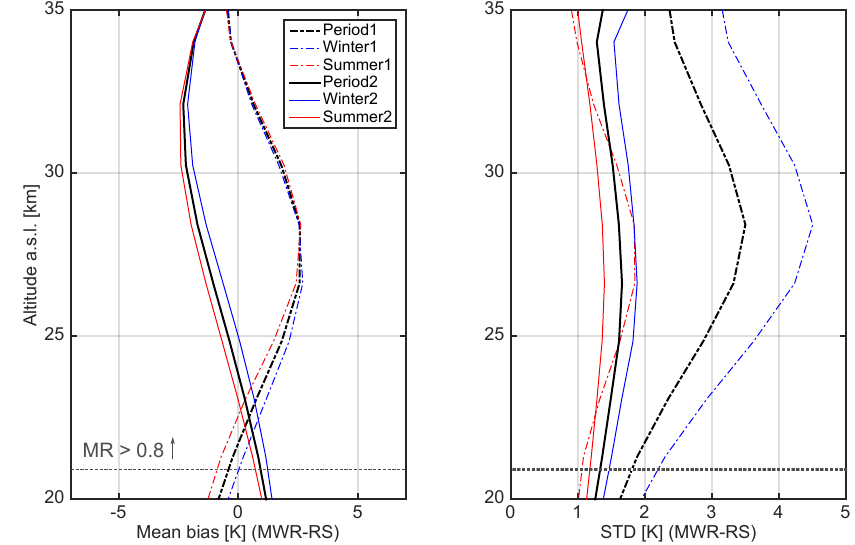
Figure 8. Mean temperature biases and standard deviations between TEMPERA and RS. A total of 1489 profiles have been compared (Period 1: 809 profiles, dashed lines; Period 2: 680 profiles, solid lines). The mean biases and the standard deviations for each period are represented by black lines. The winter season is indicated with blue lines while the summer is indicated by red lines (Winter1: 421 profiles; Summer1: 388 profiles; Winter2: 289 profiles Summer2: